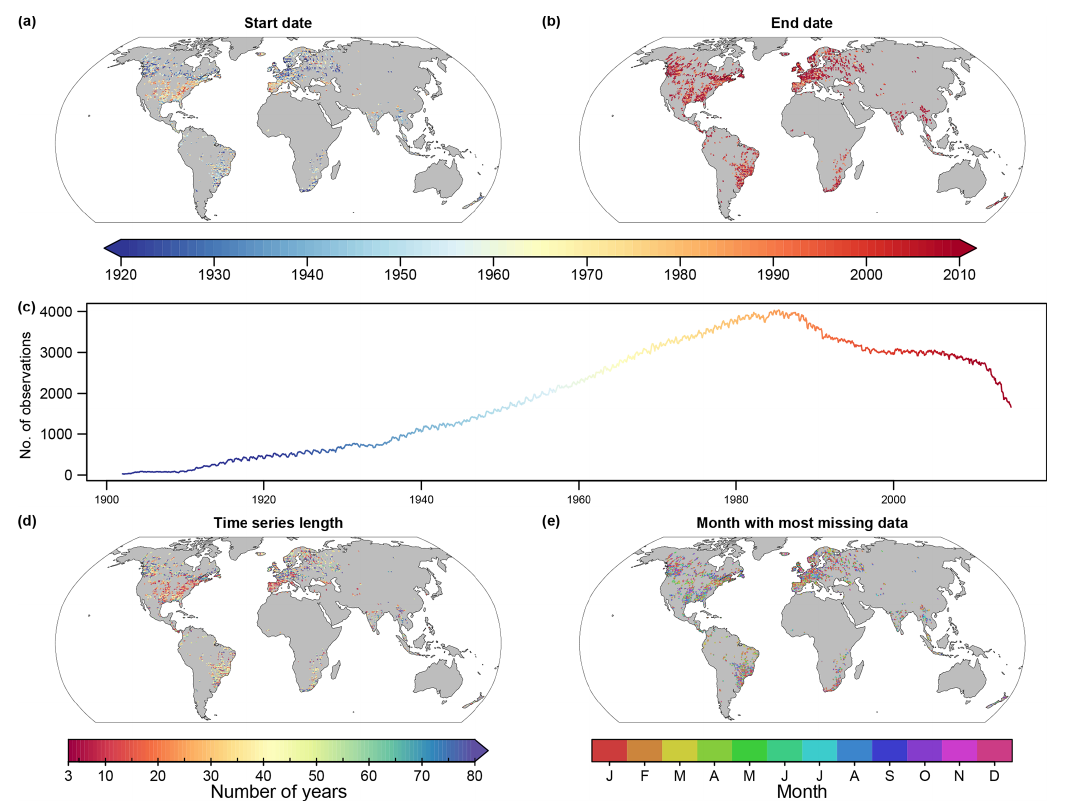
Figure 2. Spatio-temporal coverage of grid-cell runoff observations. Panels (a) and (b) display the start and end year of the time series respectively. (c) Total number of runoff observations at each month between 1902 and 2014. (d) Number of years with at least 10 runoff observations in each year. (e) Month with most missing